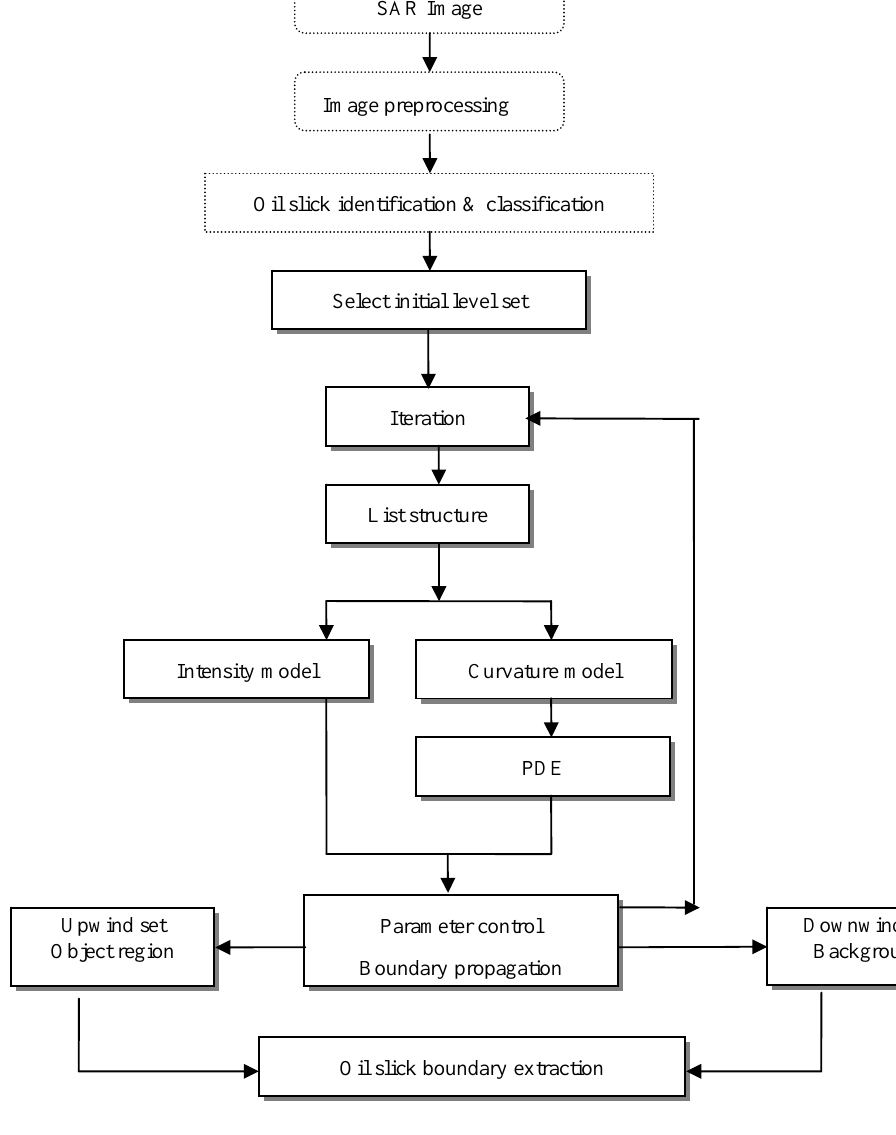
Figure 3. SAR image segmentation using the proposed fast level set